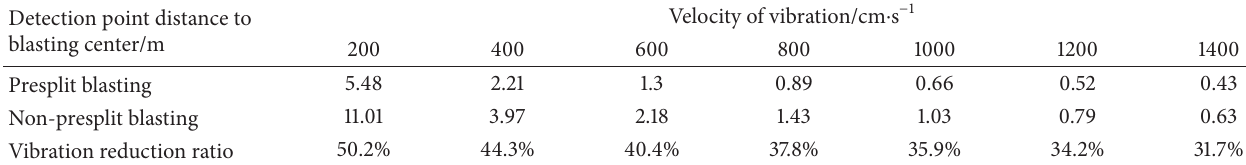
Table 5: Actual blast vibration detection data and absorption shock rate of presplit